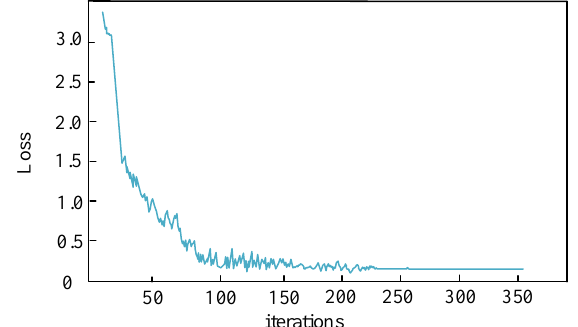
Figure 13. Curve of loss function.